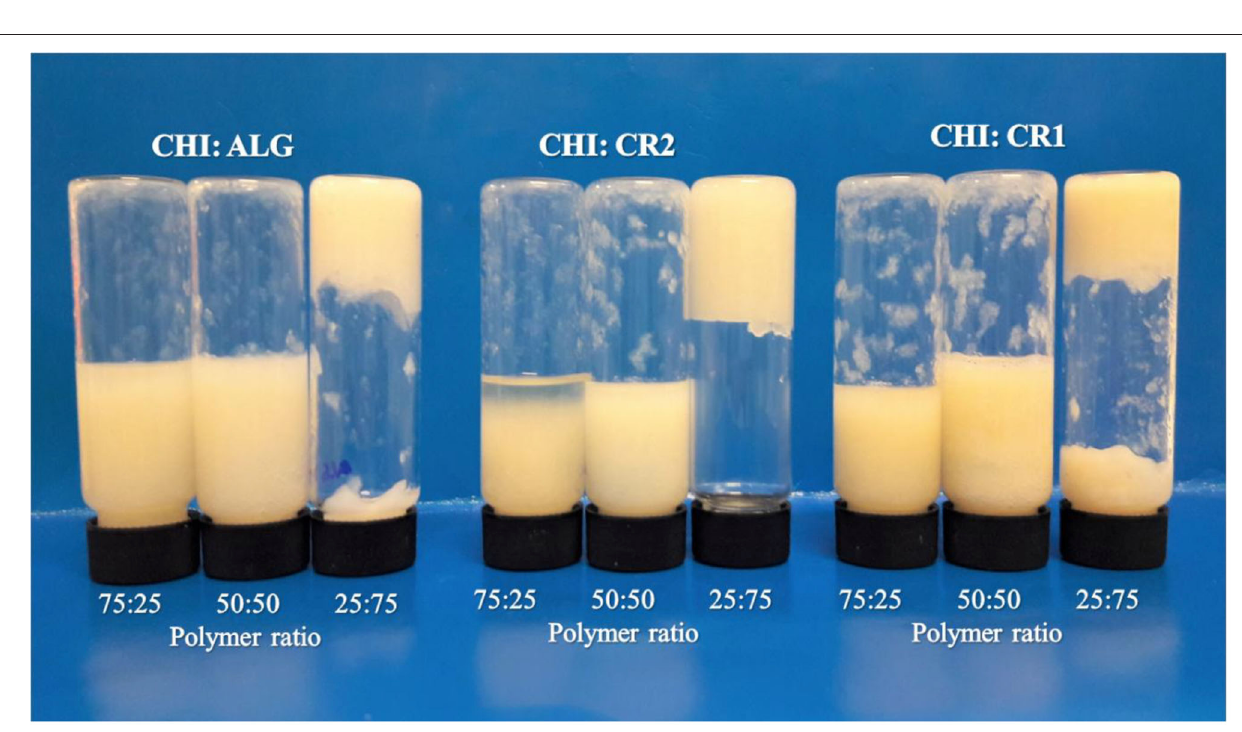
FIGURE 4 | Visual image of complex hydrogels (CHI:ALG, CHI:CR1, and CHI:CR2) at different polymer ratios (75:25, 50:50, and 25:75).